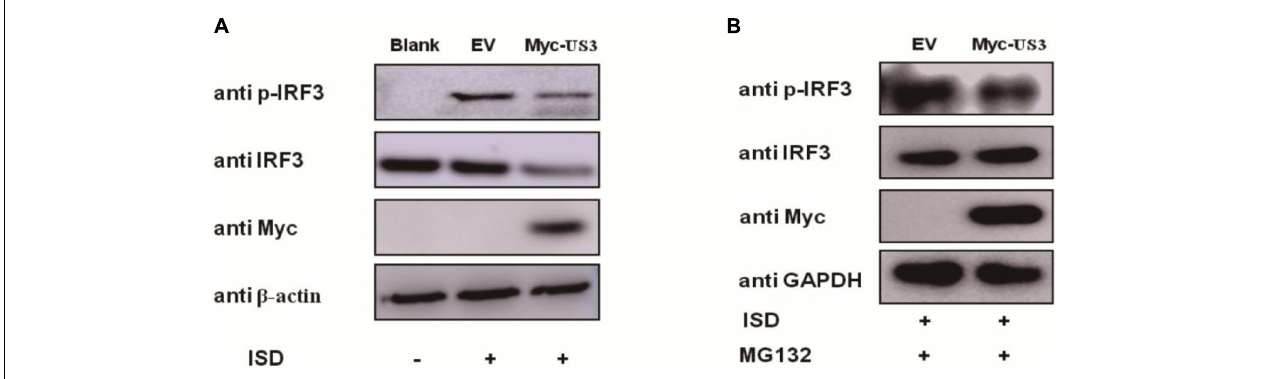
FIGURE 4 | PK15 cells were transfected with empty vector (0.5 µ g) or Myc-US3 (0.5 µ g) plasmids for 24 h and then transfected with ISD (2 µ g/mL) for 12 h. Cells were untreated (A) or treated (B) with 7.5 µ M MG132 for another 6 h before collection. IRF3, phosphorylated IRF3 (p-IRF3), and US3 protein (Myc) expression was detected by immune blotting. GAPDH or β -actin served as loading control.